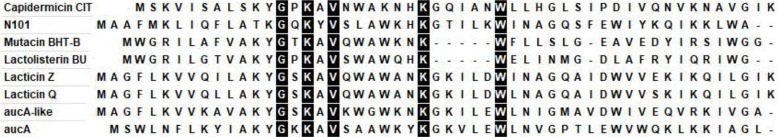
Alignment of the capidermicin amino acid sequence with homologous bacteriocins; epidermicin NI01 from S. epidermidis strain 224 (JQ025383), mutacin BHT-B from Streptococcus ratti BHT (DQ145753), lactolisterin BU from L. lactis subsp. lactis bv. diacetylactis BGBU1-4 (SDR48784), lacticin Q from L. lactis QU5 (BAF57910), lacticin Z from L. lactis QU14 (BAF75975), aureocin-like produced by numerous bacteria (SEM89646), and aureocin A53 from S. aureus A53 (WP_010976360).Highlighted residues indicate conserved amino acid sequences.